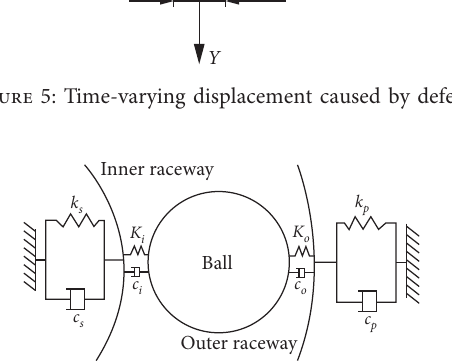
Figure 3: Kinetic characteristic of rolling element when passing defect.